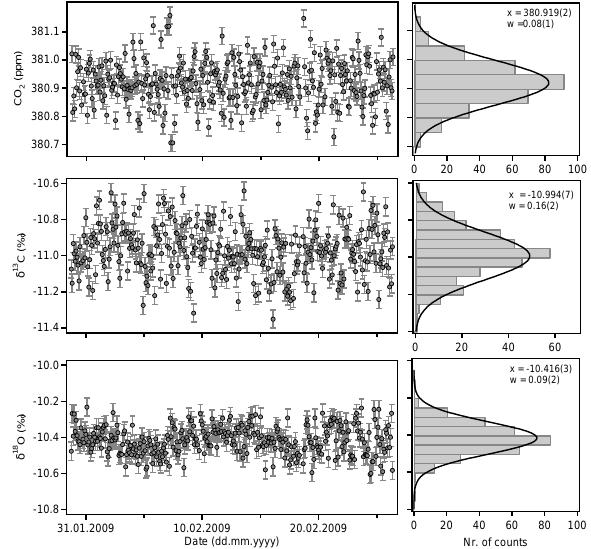
Fig. 2. Long term stability of the QCLAS. The data show repeated measurements of the secondary standard for February, 2009. The individual (cid:14) -values of each calibration step were plotted as a histogram with a 0.05‰, bin width.